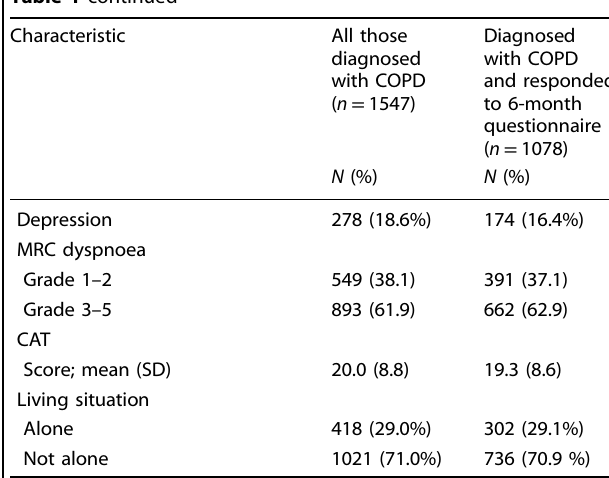
Table 1. Baseline characteristics: all those eligible for analysis